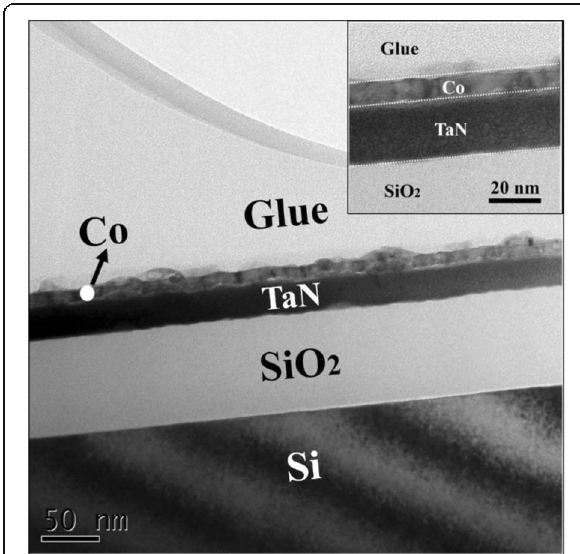
Fig. 8 The cross-sectional TEM image of the Co film (1200 cycles) deposited at 125 °C on the ALD TaN surface and the inset is a magnified